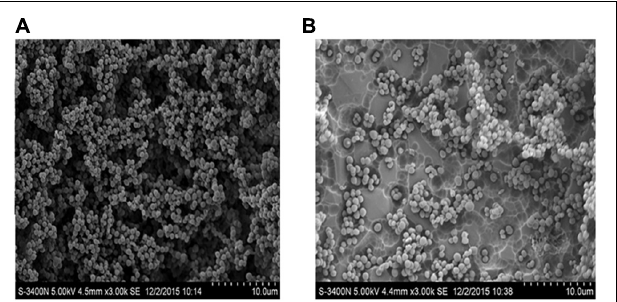
FIGURE 3 | Scanning electron microscopy of biofilm of S. suis grown in THB broth. (A) With 0 MIC (0 µ g mL − 1 ) concentration of aqueous extracts of Rhizoma Coptidis ; (B) with 1/2 × MIC (50 µ g mL − 1 ) concentration of aqueous extracts of Rhizoma Coptidis .